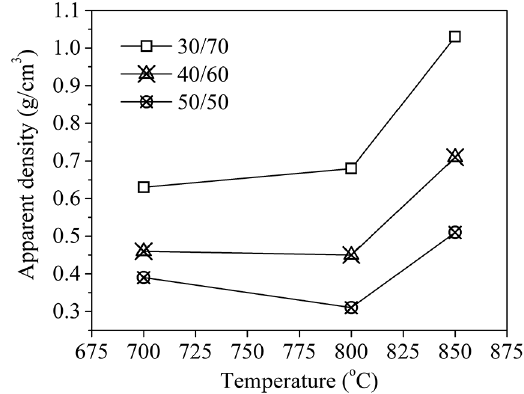
Figure 4: Effect of the firing temperature and BL content on the apparent density of the produced glass foams.